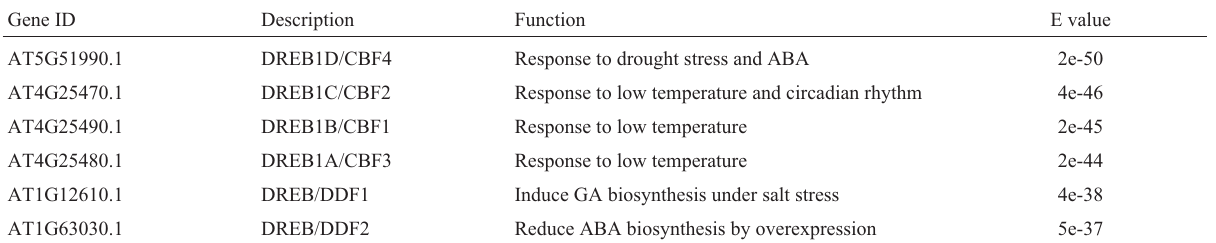
Table 2 - Homology of PnDREB1 to DREB1s in Arabidopsis